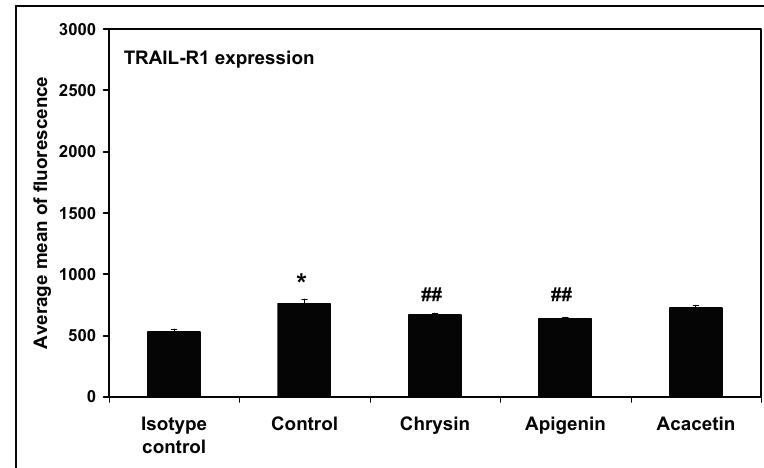
Figure 3. ( A ) Effects of flavones on TRAIL-R1 expression in RAW264.7 cells. Cells